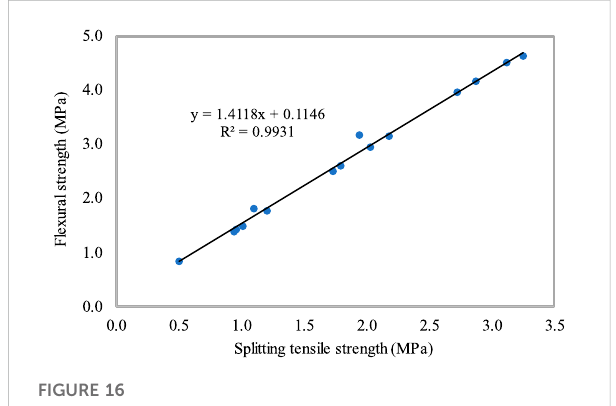
FIGURE 18 Water absorption of FC with varying weight fractions of